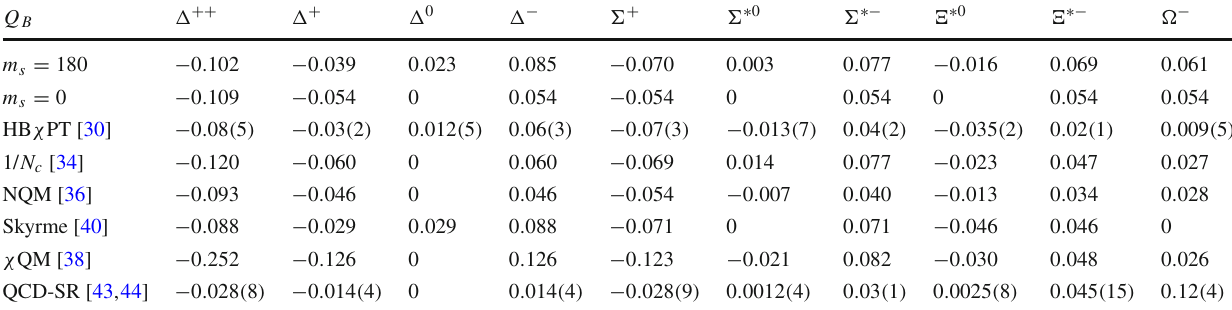
Table 4 Electric quadrupole moments of the baryon decuplet in comparison with the quark model [36], HB χ PT [30], the Skyrme model